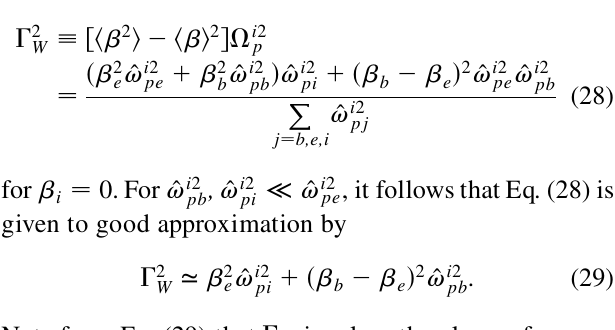
FIG. 8. Plots of (a) Weibel instability growth rate (cid:1) Im ! (cid:2) = " n (cid:7) 5 obtained from Eqs. (20) and (25). System parameters are r